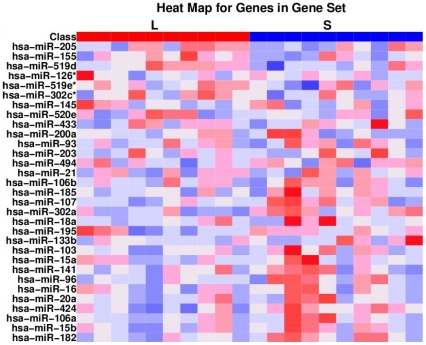
Heat map showing expression of 31 microRNAs (miRs) included in angiogenesis pathway gene set.The difference in miR expression between tumor samples from NSCLC patients with long (L) and short (S) survival is shown. miR expression values are shown in a spectrum where down-regulated is blue and up-regulated is red.